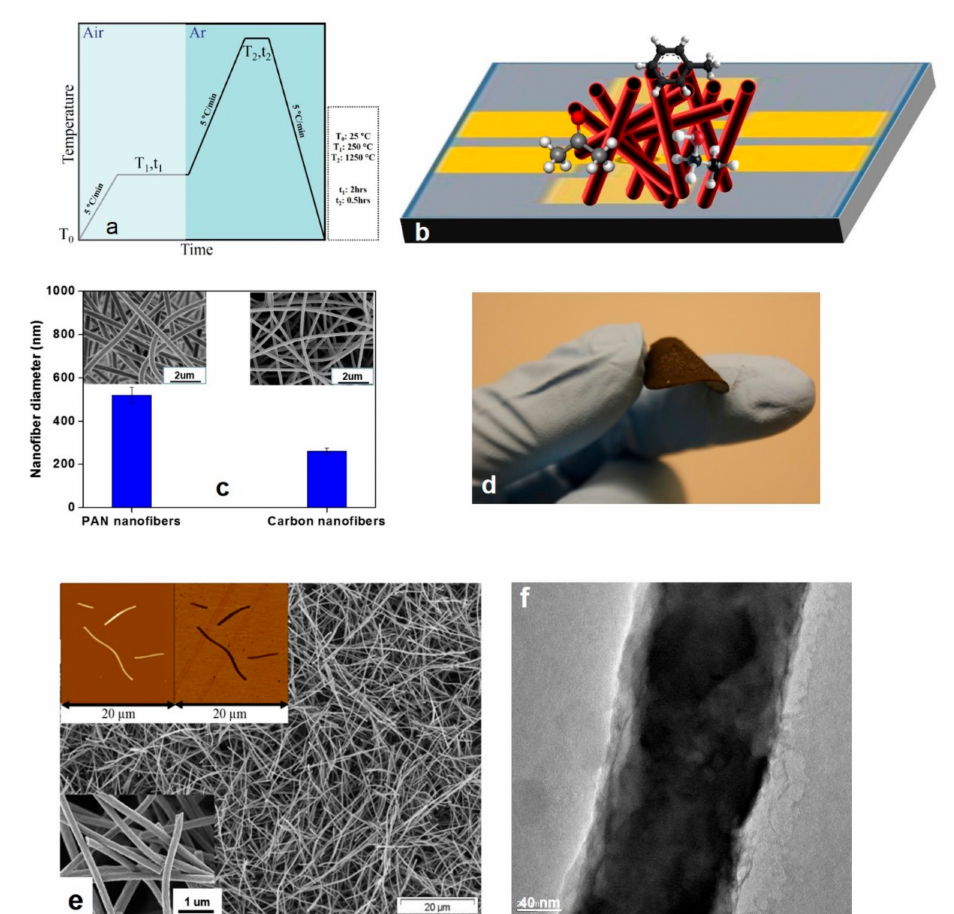
Figure 2. ( a ) The step-wise production process of a-CO x / G nanofibers; ( b ) the schematic illustration of the gas sensing set-up comprising a glass substrate overlaid by gold contact electrodes, where the nanofilaments sit and are exposed to the gas analytes; ( c ) morphology and dimensions of the a-CO x / G nanofibers (the nanofibers’ diameter shrinks within the course of the graphitization process); ( d ) the camera image shows the flexibility of the buckypaper; ( e ) morphology and dimensions of the chopped a-CO x / G nanofilaments (the inset pictures are the atomic force microscopy (AFM) micrographs showing morphology and dimension of individual nanofilaments (upper left) and the SEM micrograph showing morphology of the nanofilaments at a high magnification (lower left)); ( f ) TEM image indicates the presence of two distinct regions distinguished by their di ff erent color intensity. The darker regions imply the aligned, graphitic, and dense arrangement of carbon elements, while the brighter regions are related to sparse and haphazard amorphous